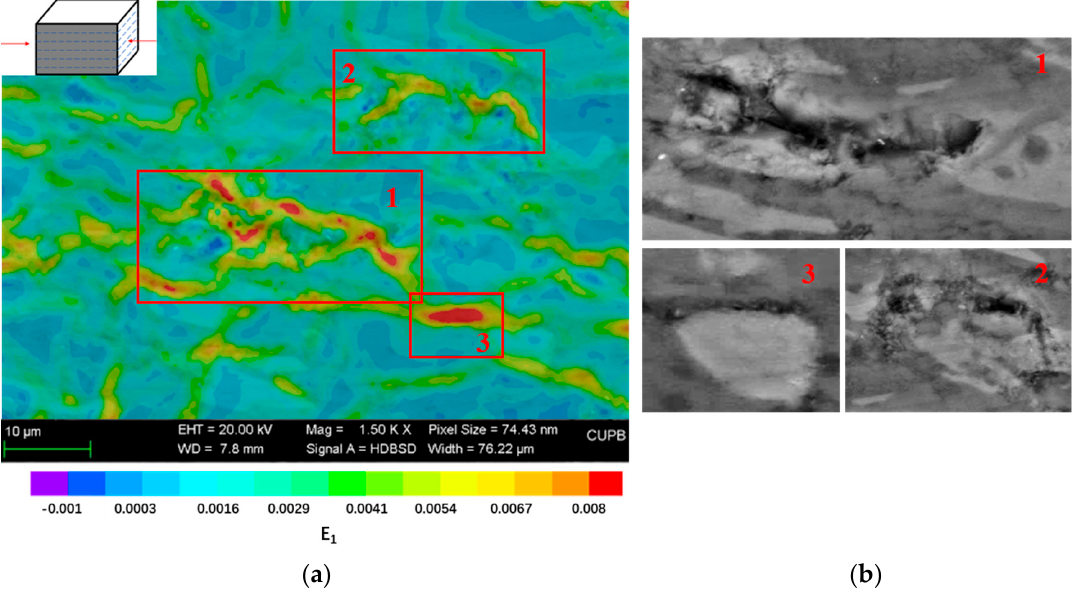
Figure 4. Microstructure deformation when bedding angle is 0°: ( a ) E 1 cloud chart; ( b ) 3 microcracks. The marked numbers correspond to the positions in Figure 4a.